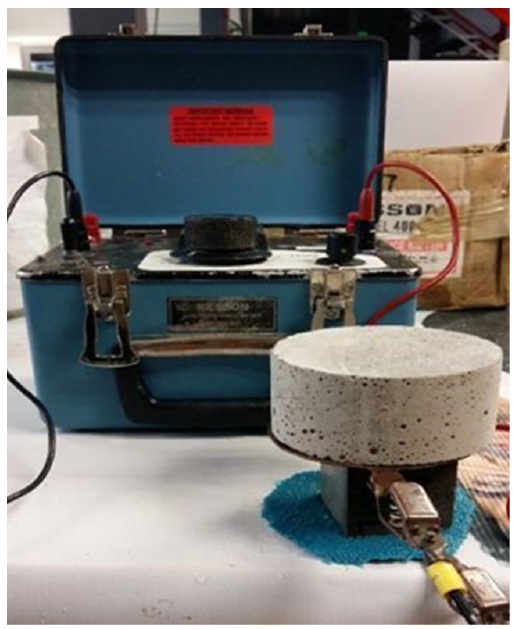
Figure 5. Illustration of the electrical resistivity test and equipment.